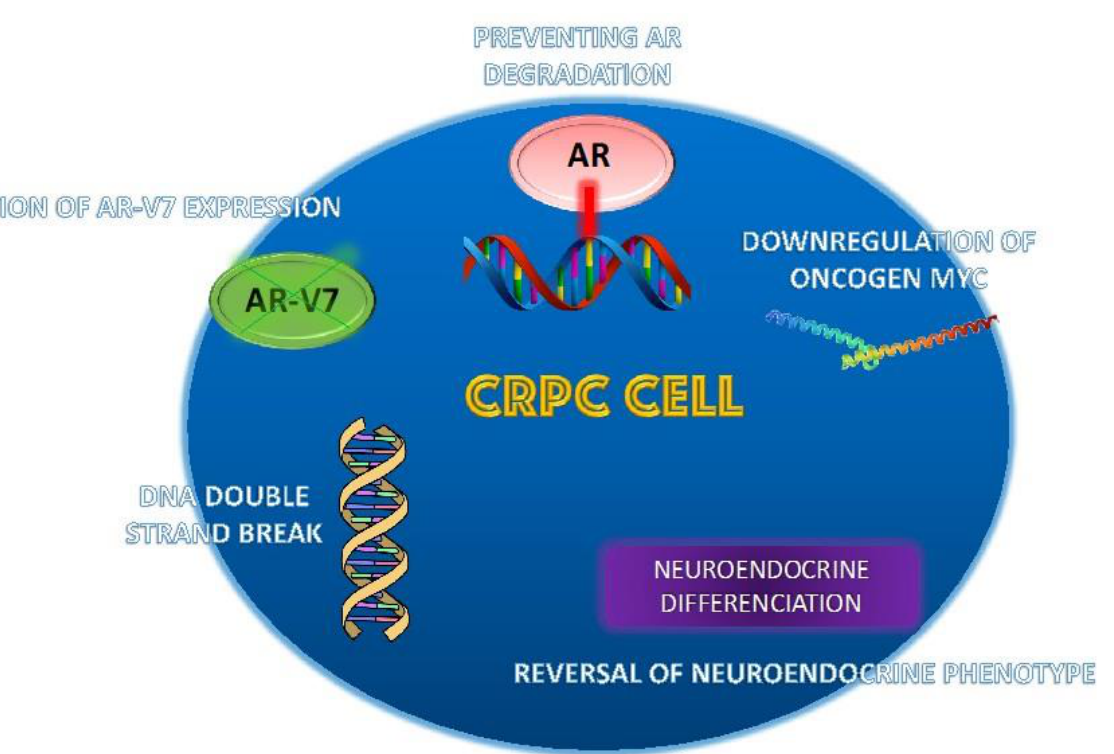
Figure 3. Proposed mechanisms of action of bipolar androgen therapy (BAT). Different mecha- nisms have been proposed—Induction of genomic instability through DNA double-strand breaks— Stabilization of the link between DNA and the AR, preventing AR degradation and DNA relicensing during the cell cycle—Modulation of oncogene expression (downregulation of oncogene Myc)— Inhibition of AR-V7 expression—Reversal of transition to the neuroendocrine